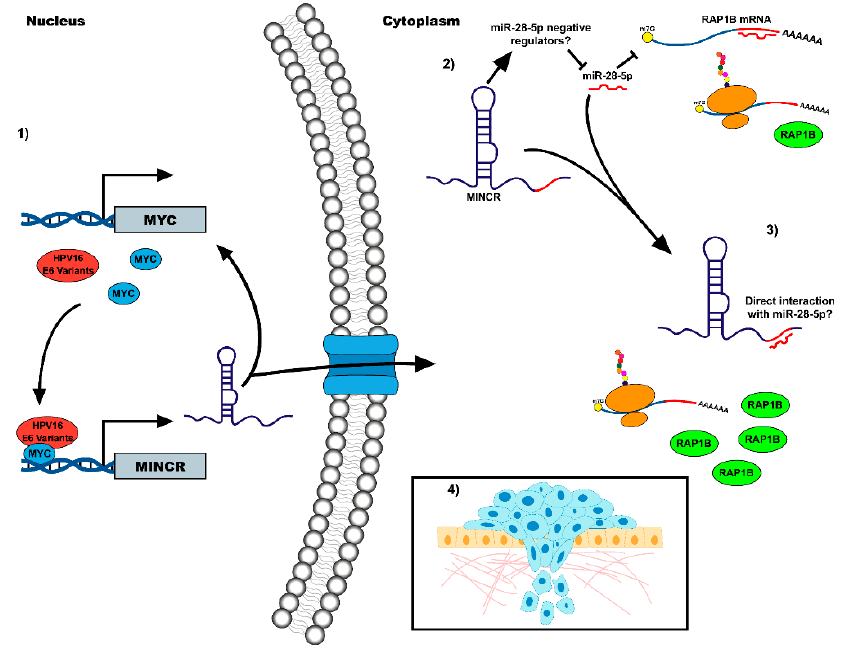
Figure 5. Schematic model of the mechanisms of the HPV16 oncoprotein E6 on the MINCR/miR ‐ 28 ‐ 5p/RAP1B axis. ( 1 ) Through its interaction with the transcription factor MYC, the oncoprotein E6 activates the expression of MYC target genes, including MINCR. The expression of the HPV16 E6 oncoprotein variants in a cervical cancer model induces overexpression of MINCR, which is involved in the control of the MYC transcriptional network, thus generating a positive feedback between both genes. ( 2 ) In the cytoplasm, MINCR inhibits miR ‐ 28 ‐ 5p activity on RAP1B mRNA through some possible mechanisms: the direct interaction of MINCR with the miRNA or the activation of negative regulators of miR ‐ 28 ‐ 5p. ( 3 ) A reduction in the activity of miR ‐ 28 ‐ 5p on its target mRNAs allows an increase in RAP1B mRNA and protein. ( 4 ) RAP1B overexpression promotes cell migration in cervical cancer cells.